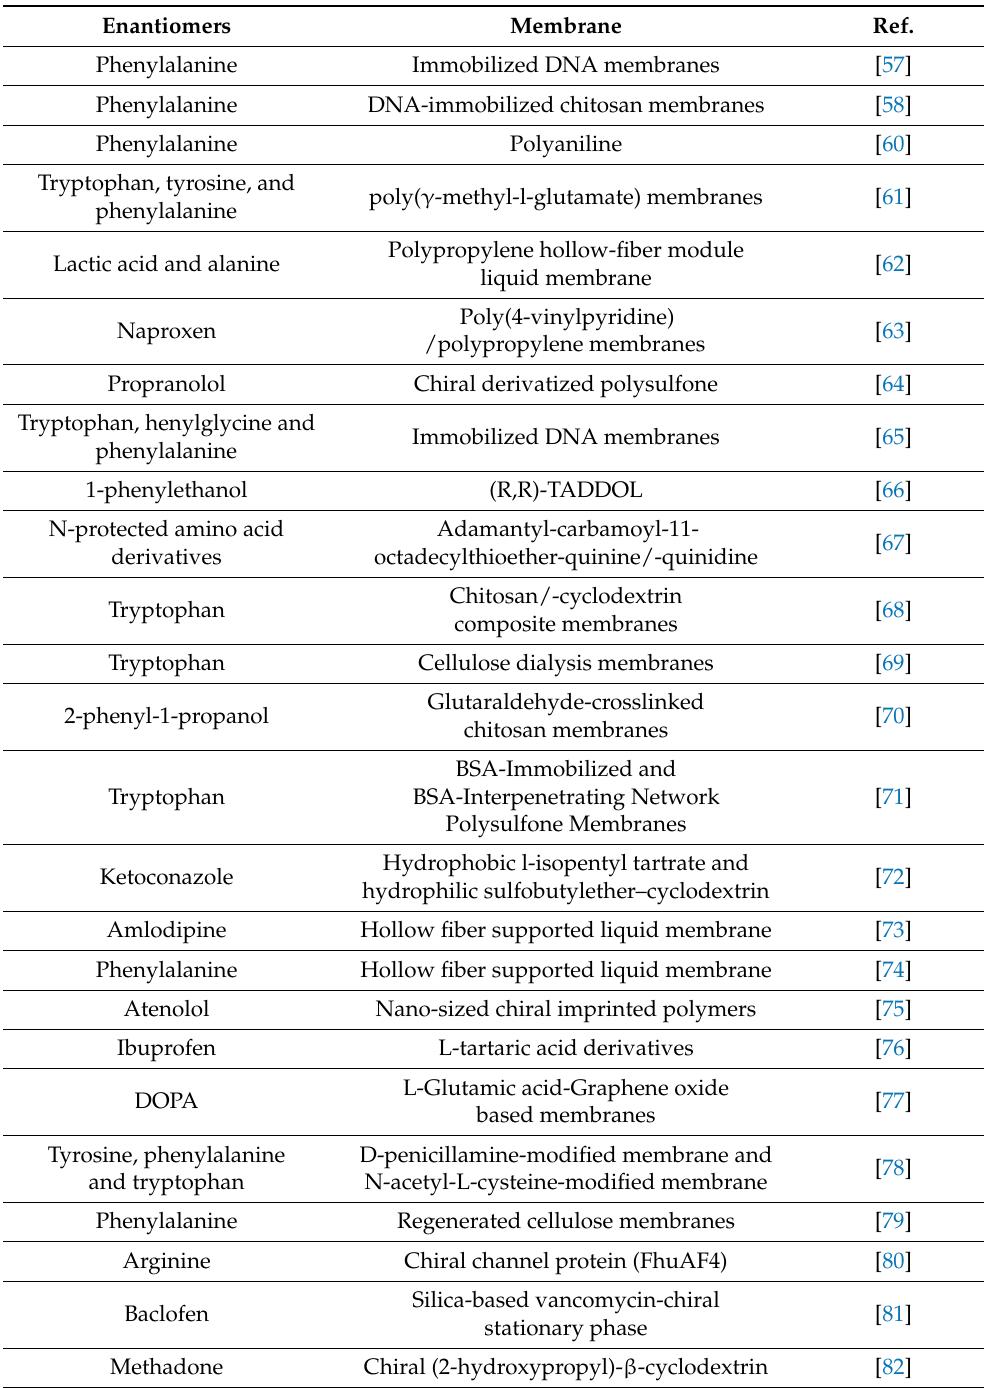
Table 6. Experimental studies of enantioresolutions applying